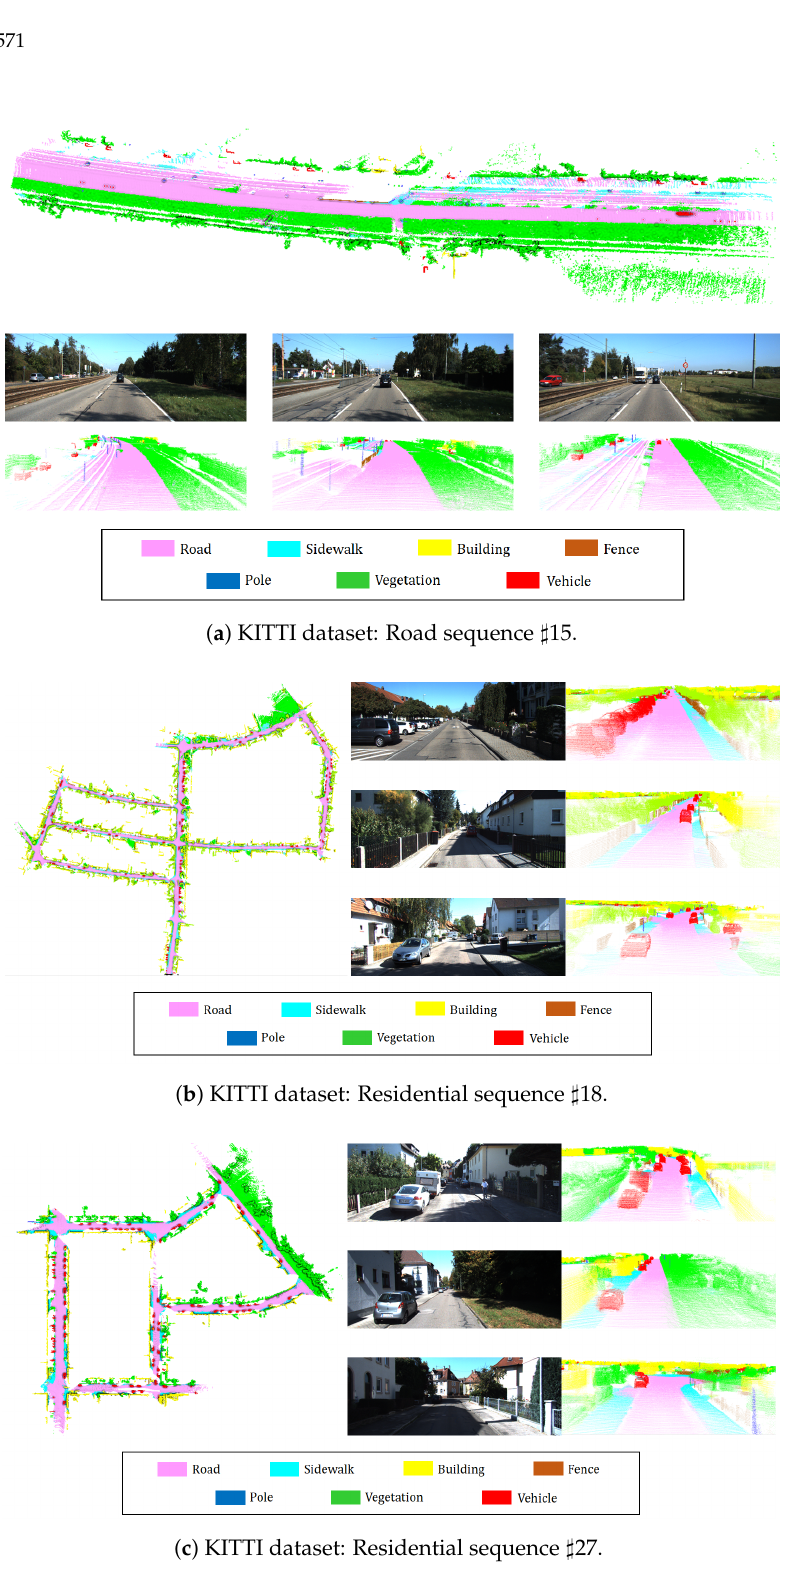
Figure 7. Visualization of semantic 3D mapping results. Top view for the entire map and three close-up views with different